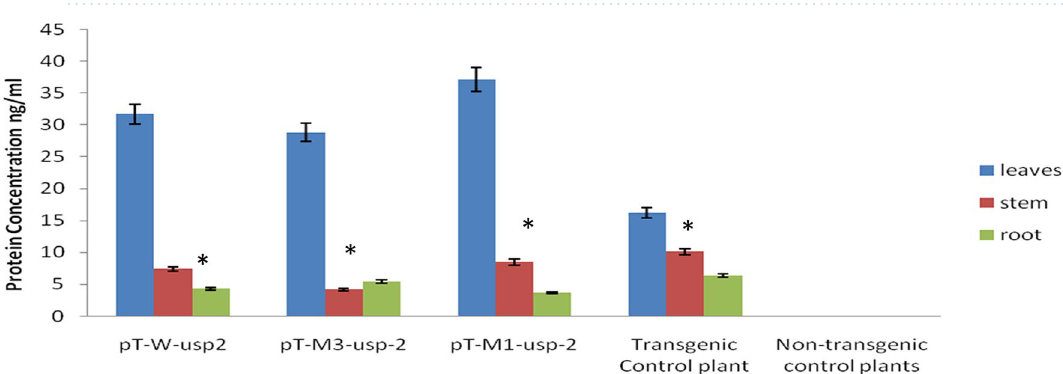
Figure 11. Concentration of wild type and mutated GUSP-2-proteins in different tissues of pT- W-usp-2 , pT- M1-usp-2 & pT- M3-usp-2 transgenic cotton plants.